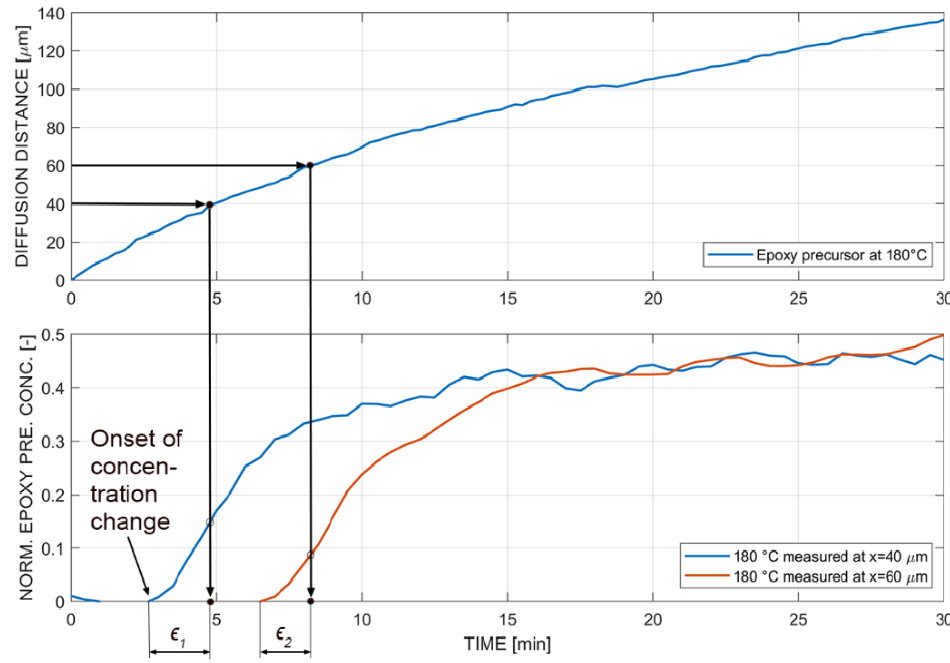
Figure 13. Comparison of in situ Raman diffusion measurements with optical hot stage experiments with the epoxy precursor.